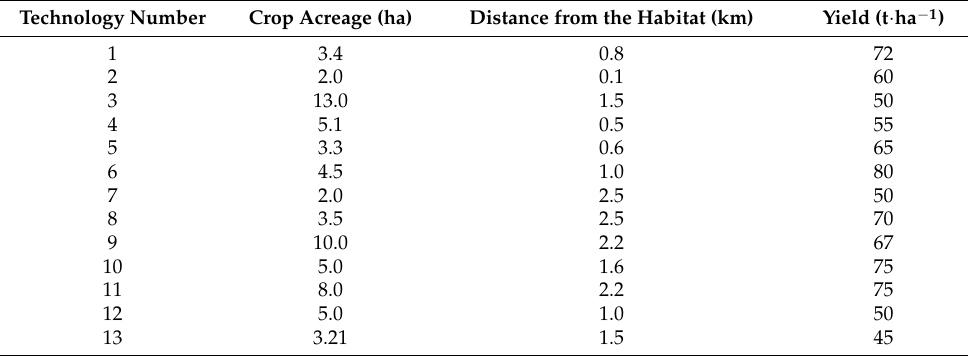
Table 3. Selected elements characteristic for silage maize